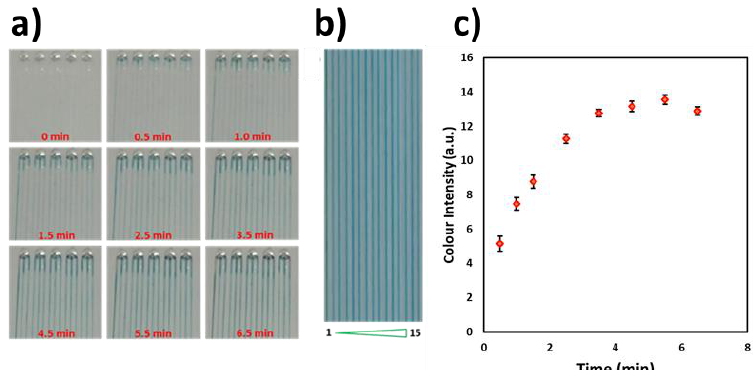
Figure 3. Horseradish peroxidase (HRP)-cortisol-coated microchip dipped in a 3,3′,5,5′ - tetramethylbenzidine (TMB) solution. ( a ) Time-lapse photos of the cortisol assay progressing in the microchannels at different times (0.5, 1.0, 1.5, 2.5, 3.5, 4.5, 5.5 and 6.5 min), ( b ) Still photograph after completion of the reaction at 6.5 min. Colour intensity variability in the 15 channels was found to be 2% (%RSD). ( c ) Graph showing the colour intensity change at different times.